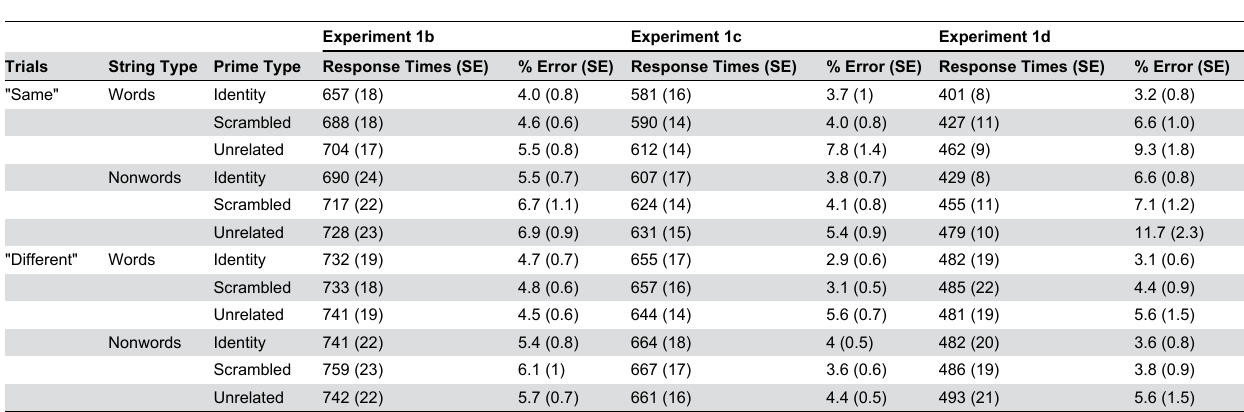
Table 2. Mean response times in milliseconds, percentage errors, and standard error (SE) of the means of Experiment